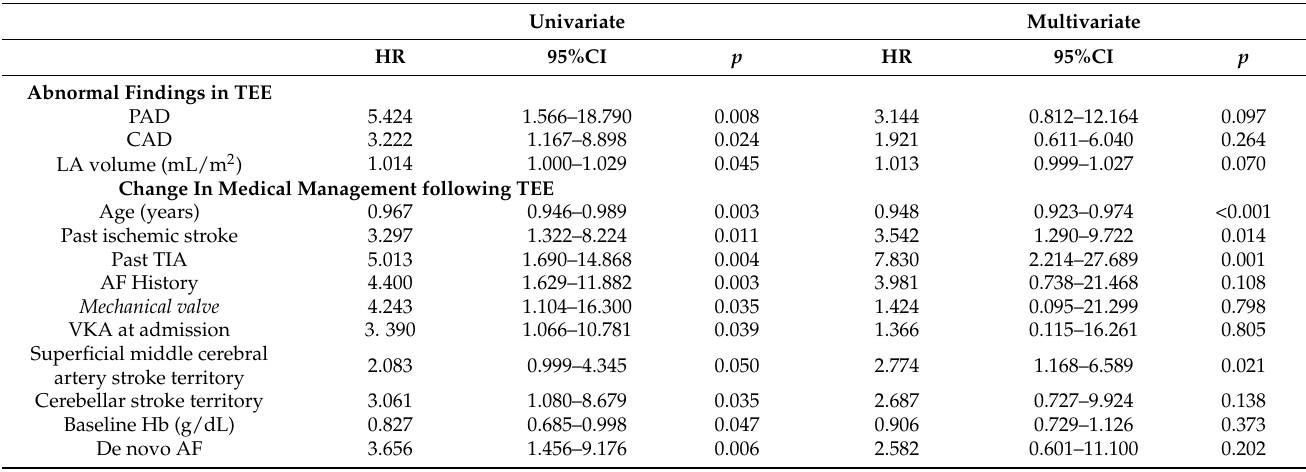
Table 6. Predictors of Abnormal Findings in Transesophageal Echocardiography (TEE) And Subsequent Change in Medical Management following